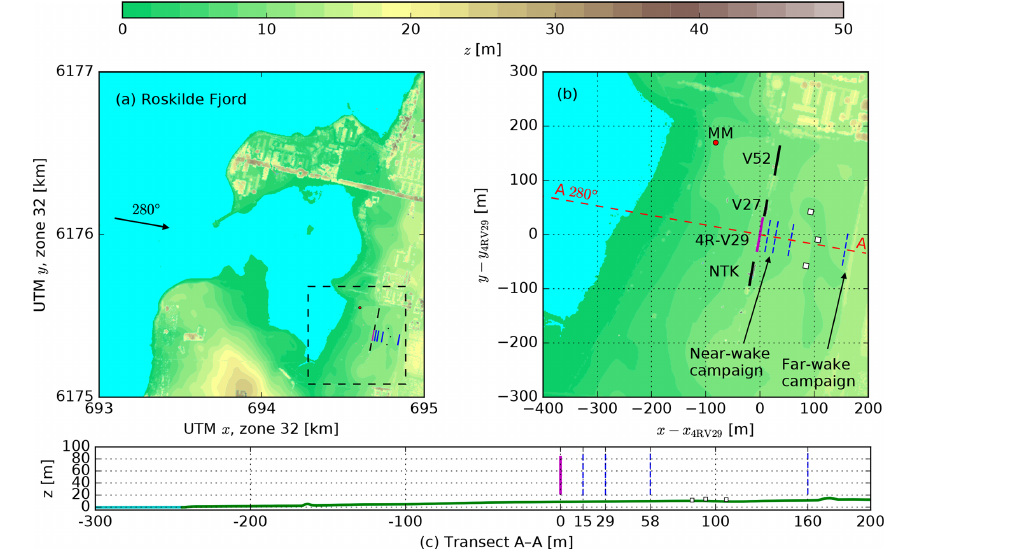
Figure 5. Topography around the 4R-V29 wind turbine, and an overview of wake measurements. Panel (b) is a zoomed-in section of panel (a) . (c) The terrain height along transect A–A. The locations of three WindScanners are shown as white squares, the scanning locations are shown as blue dashed lines, MM is the met mast, and V52, V29 and NTK are neighboring wind turbines.